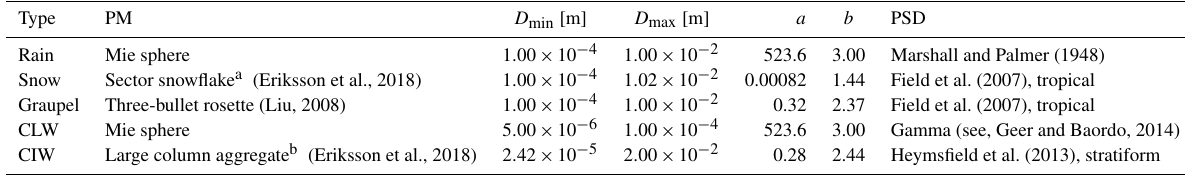
Table 1. Microphysical setup for all the hydrometeors: PM denotes the particle model, PSD is the particle size distribution, CIW stands for cloud ice water, and CLW is the cloud liquid water. D min and D max denote the respective hydrometeor minimum and maximum sizes of the maximum diameter, and a and b comprise the coefficients of the mass–size relation that links the hydrometeor mass ( m ) to its size (maximum or geometric diameter; D ), i.e., m = a · D b